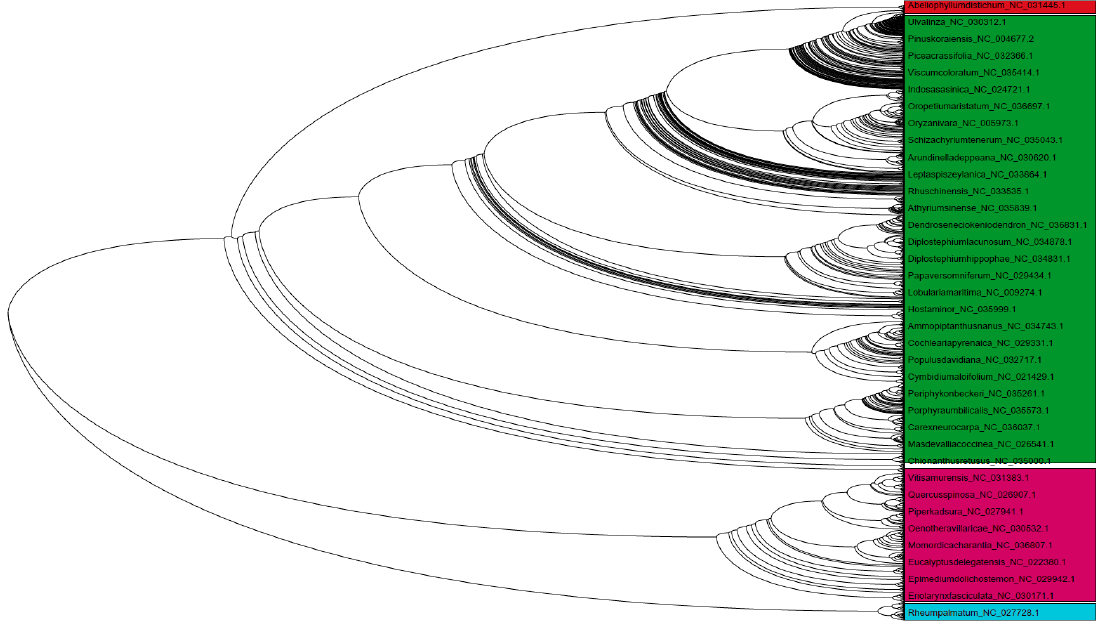
Figure 6. Phylogenetic tree of chloroplast genomes. The phylogenetic tree showed the presence of four major clusters in the chloroplast genomes, suggesting their evolution from multiple common ancestral nodes. The phylogenetic tree considered all of the genomes used during the study and was constructed by a Neighbor-joining program with 500 bootstrap replicates and ClustalW.